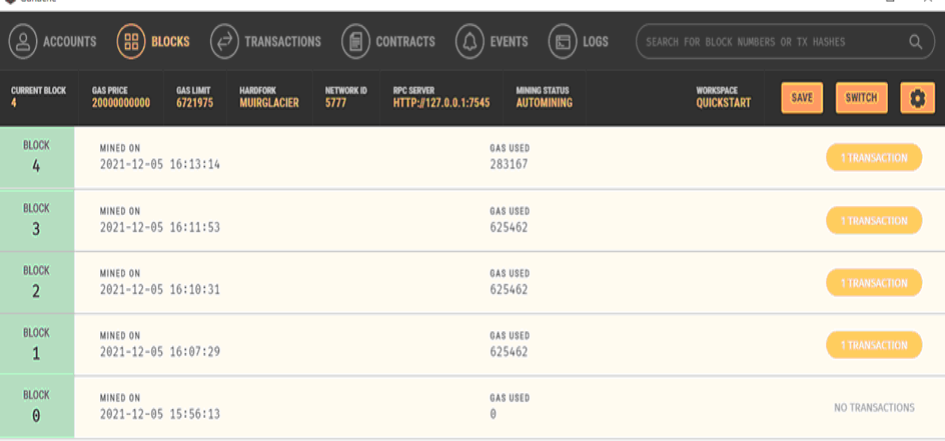
Figure 12. Paid transaction.